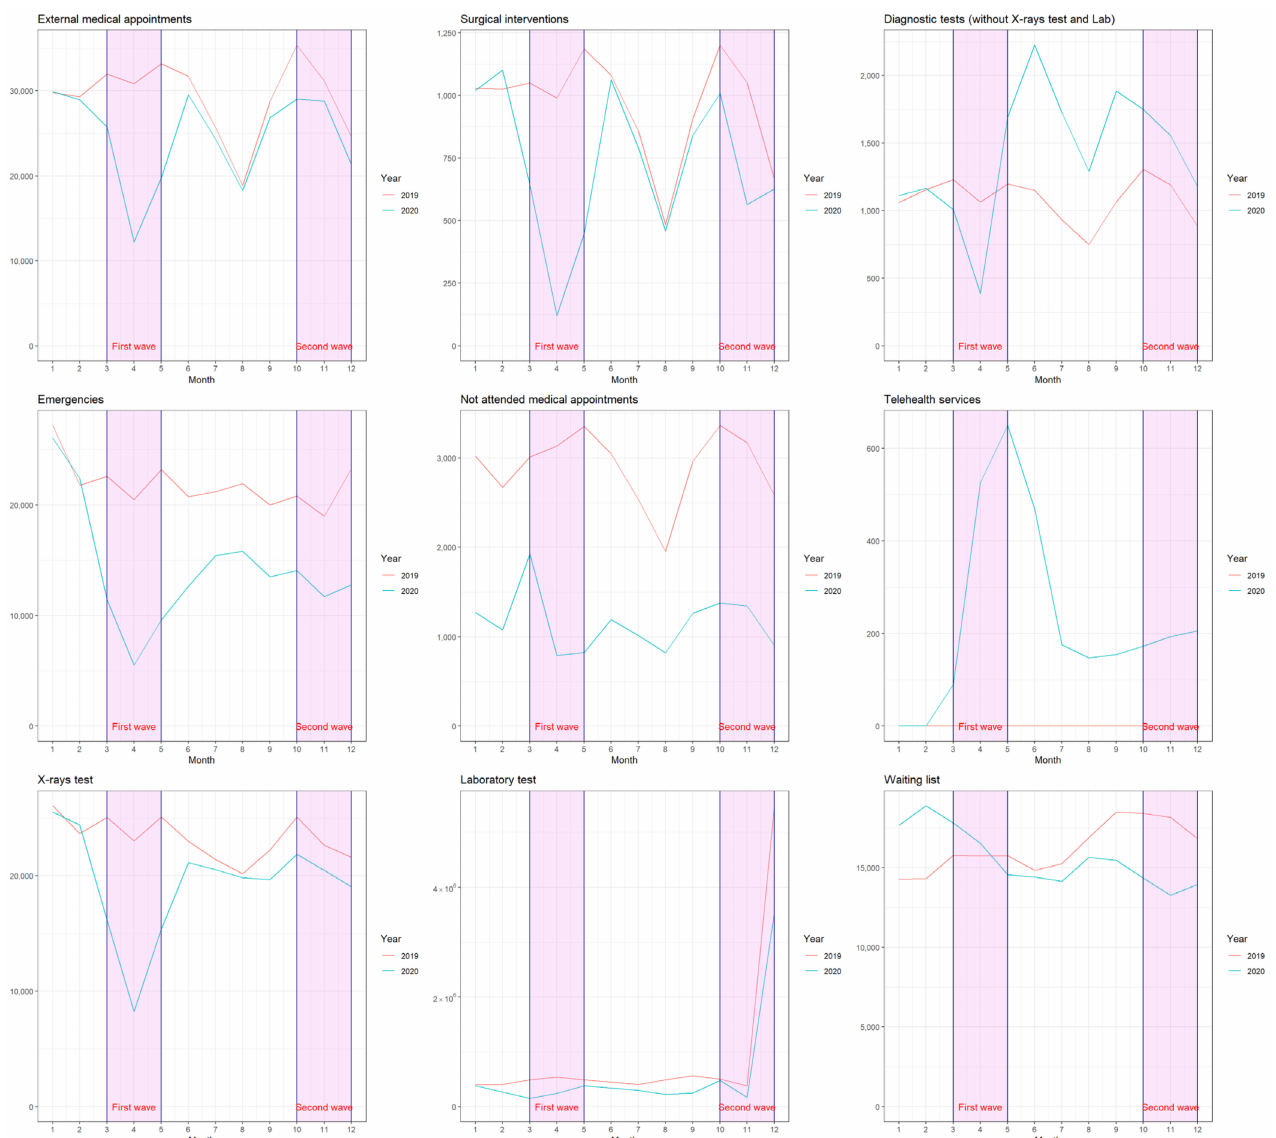
Figure 1. Monthly evolution for the years 2019 and 2020 in the Alto Guadalquivir Health Agency. The first wave and lockdown of Covid-19 in Spain took place between March and May 2020, while the second wave and semi lockdown was between October and December 2020. These results coincide with those achieved by PH (Figure 2); the levels of the variables did not recover throughout 2020, except for X-ray and laboratory